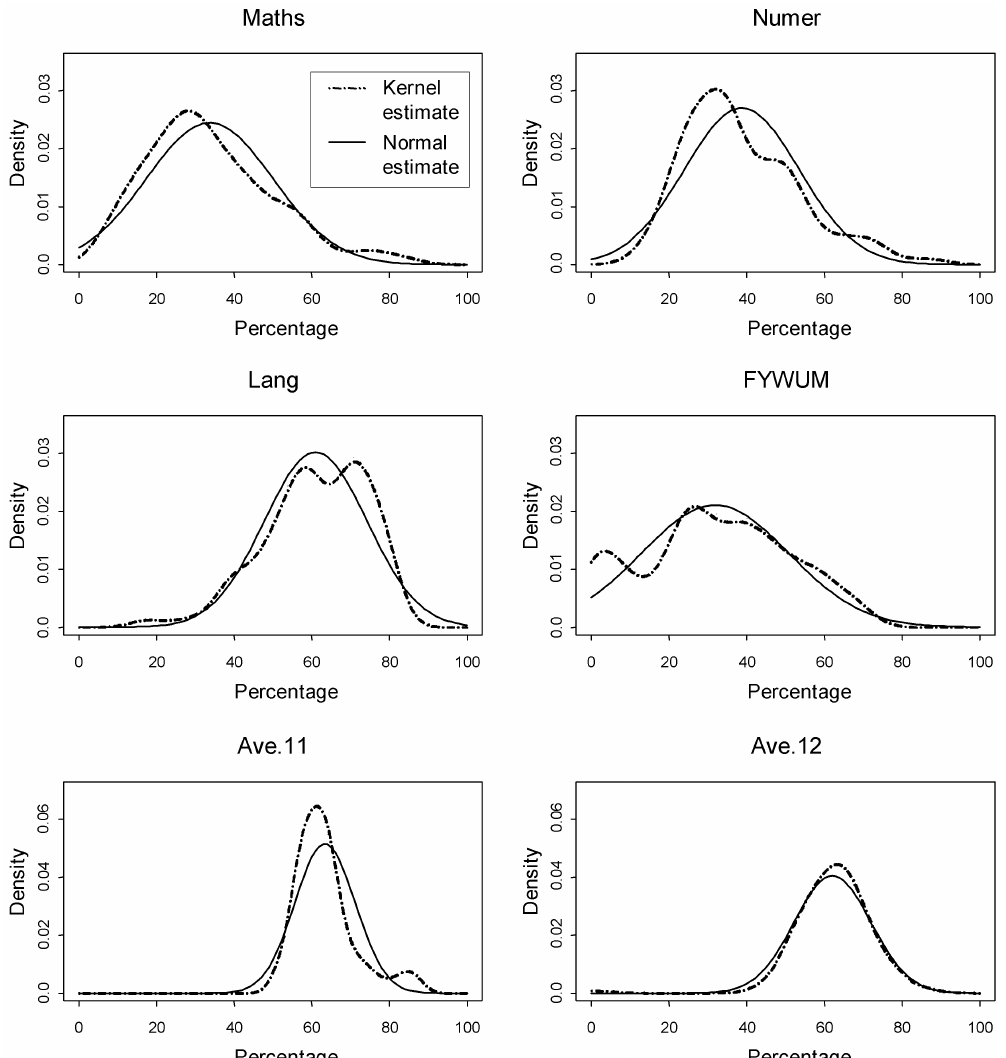
Figure 6: Parametric normal and non-parametric kernel density estimates for selected variables of Test Battery 2, 1999 intake